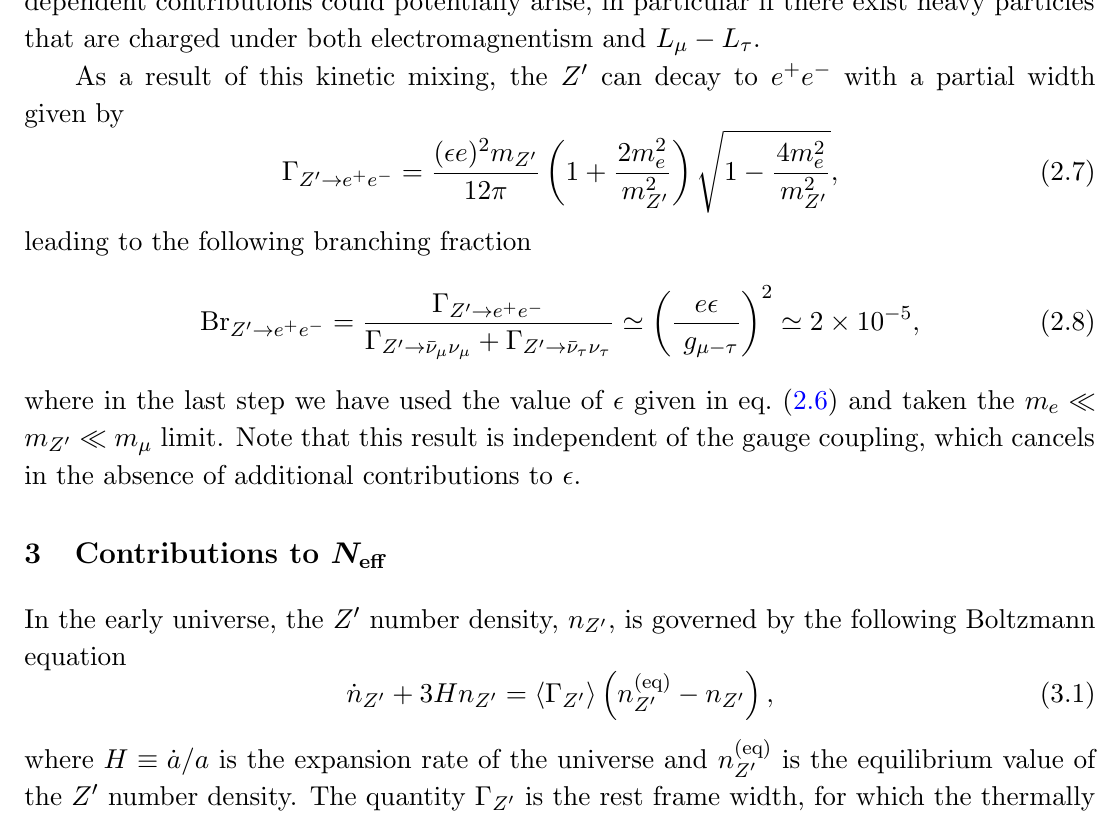
. For a treatment of (cid:22) (cid:0) L (cid:28)